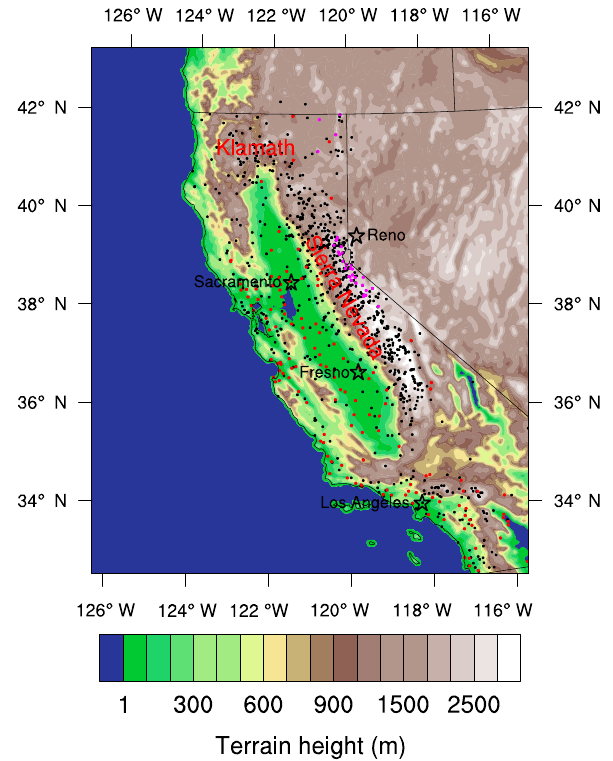
Figure 1. Model domain and terrain height (m). 991 DWR sites are represented by black dots; 138 CIMIS stations are represented by red dots; 32 SNOTEL sites are represented by magenta